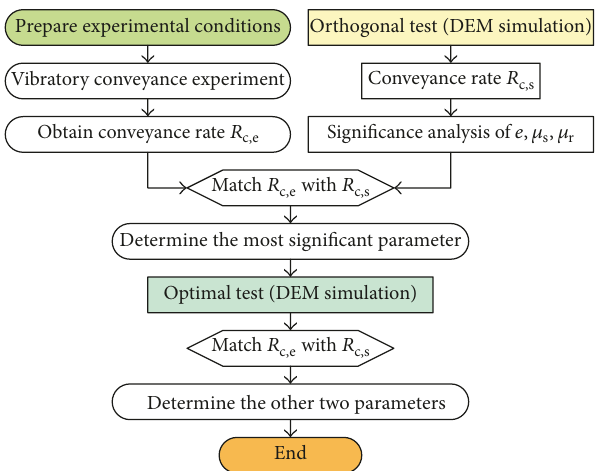
Figure 3: Procedure to determine the microcontact parameters for the DEM